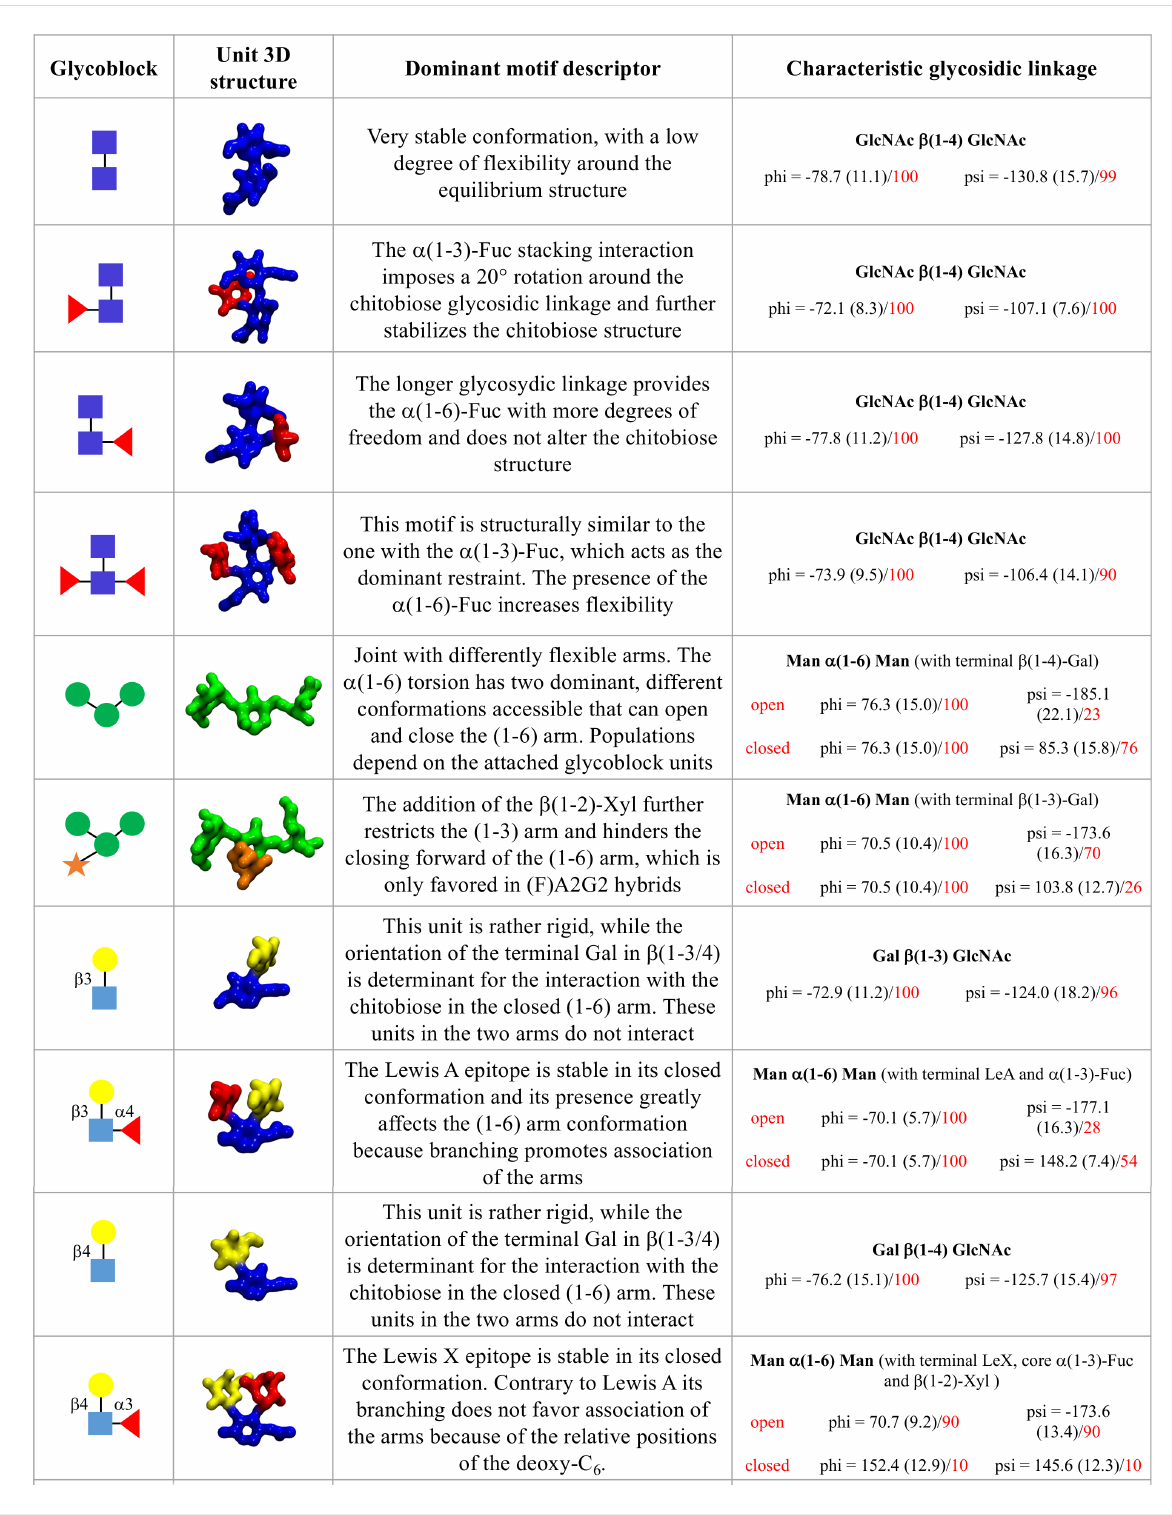
Figure 7: List of 3D structural units of monosaccharides (glycoblocks) that regulate the 3D architecture and dynamics of complex biantennary N-glycans from plants and invertebrate sources and hybrid mammalian constructs. The SFNG representation of each glycoblock is indicated in the first column from the left, 3D structures from the highest populated conformers are shown in the second column, rendered with VMD (https:// www.ks.uiuc.edu/Research/vmd/). A brief summary of the conformational features of each glycoblock and the characteristic linkage or its effect on the (1-6) arm conformation are indicates in the last two columns,